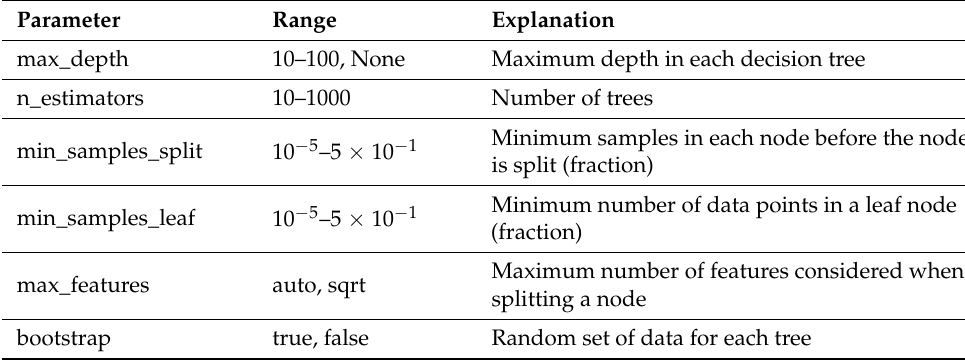
Table 2. Parameters and ranges used in hyperparameter